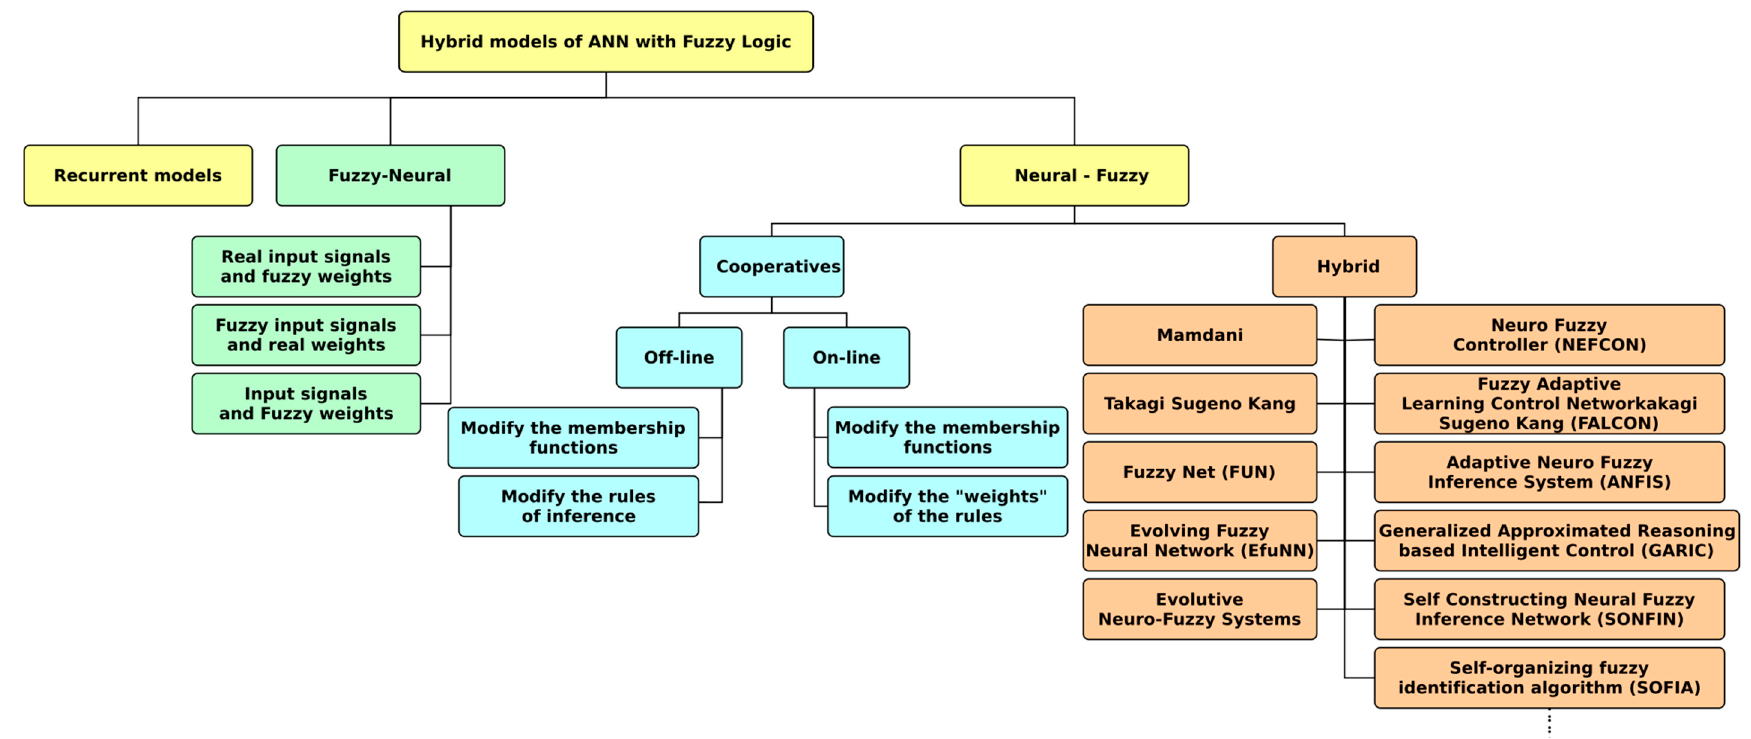
Figure 16. ANN and fuzzy logic hybrid models. Source [189], own elaboration.